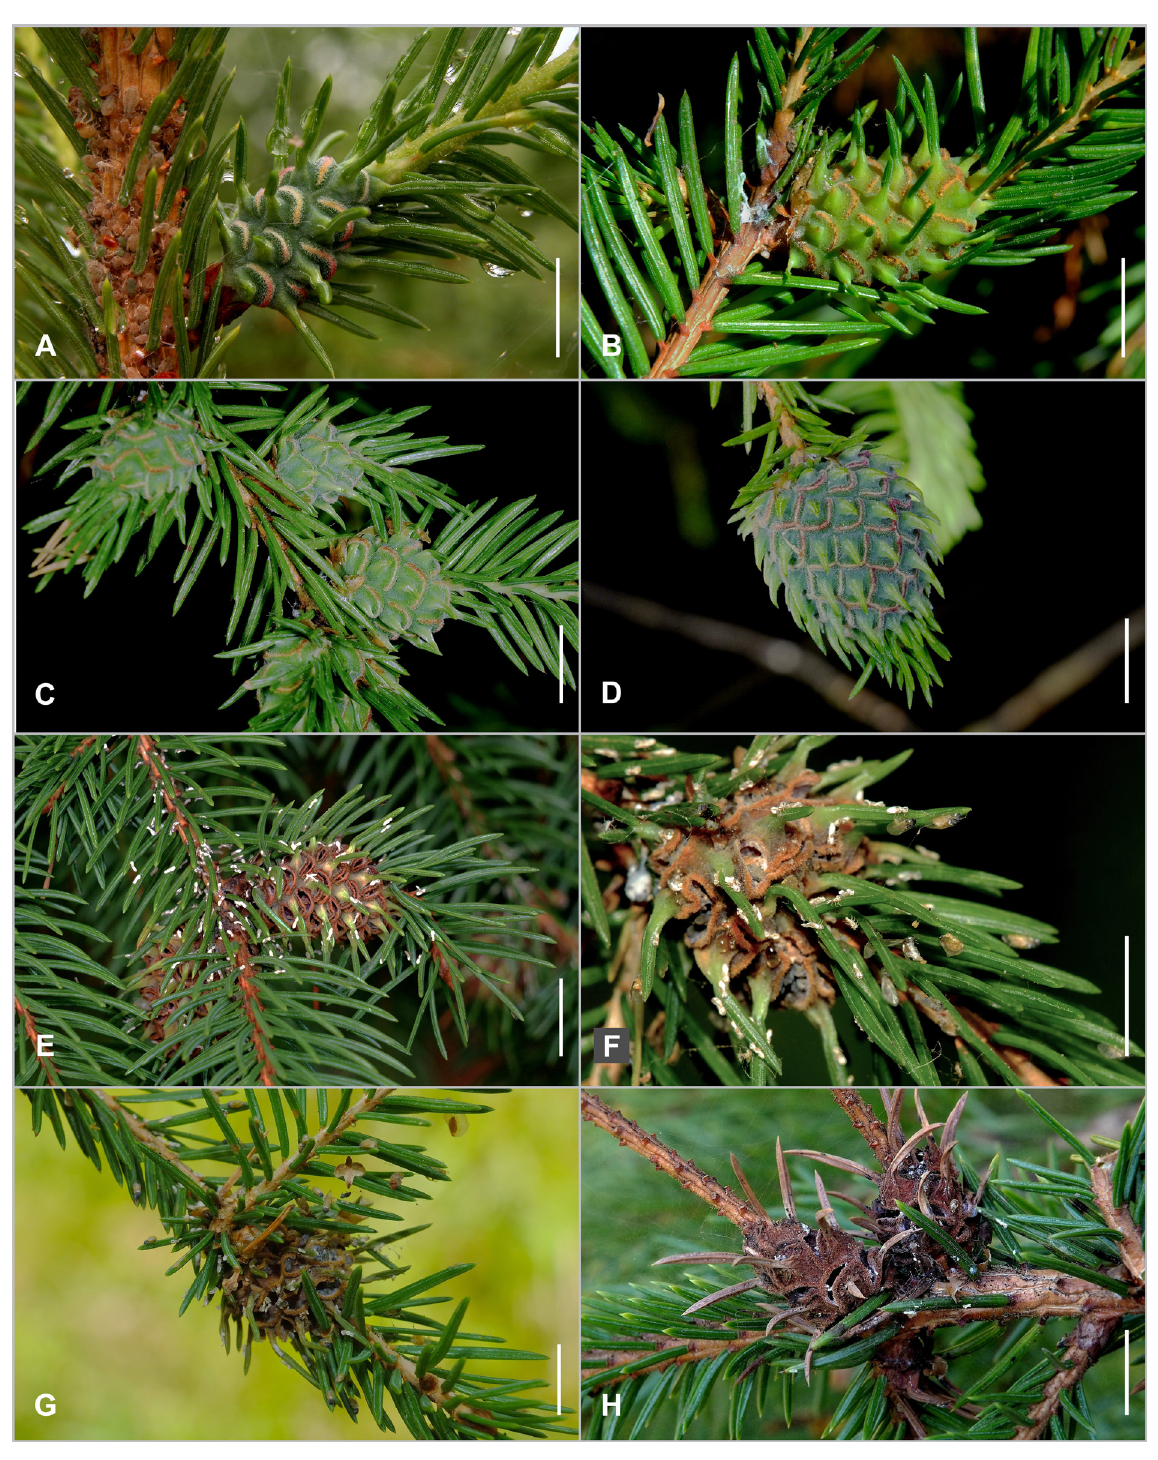
Fig. 18. Adelges (Sacciphantes) abietis (Linnaeus, 1758), galls on Picea abies . A–D . Galls from different sites showing variation in colouration. A . From a semi-open site. B . In semi-shade. C–D . In deep shade. E–F . Newly opened galls with exuviae and alate gallicolae around. G–H . Galls from previous summer. Note the colony of Cinara pilicornis (Hartig, 1841) on the stem in A. Scale bars: 10